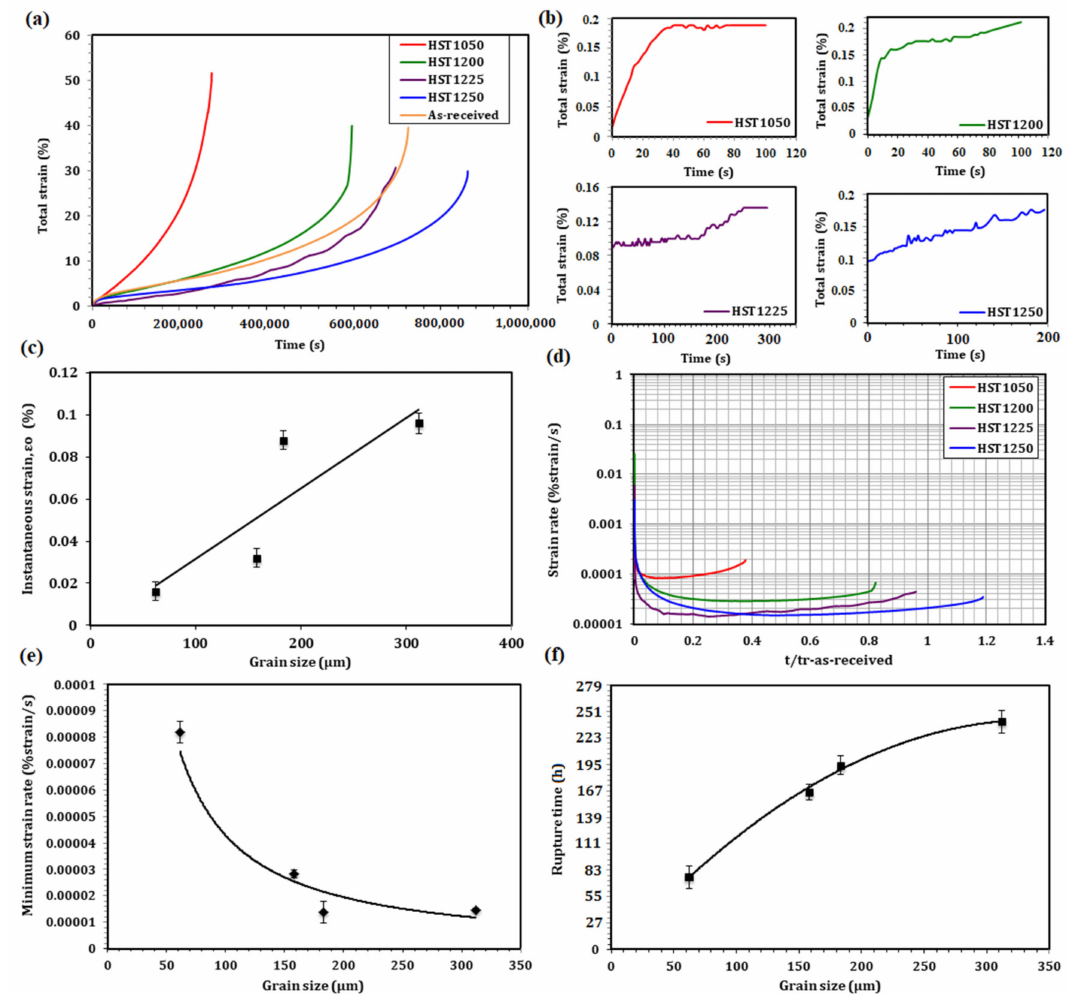
Figure 3. Creep curve of heat-treated Fe-40Ni-24Cr at temperature 800 ◦ C and initial stress of 100 MPa; ( a ) total strain versus time ( b ) instantaneous creep strain and ( c ) instantaneous strain versus grain size and ( d ) strain rate versus time ( e ) minimum creep rate versus grain size. ( f ) Creep rupture time versus grain size of heat-treated Fe-40Ni-24Cr after creep test at 800 ◦ C and 100